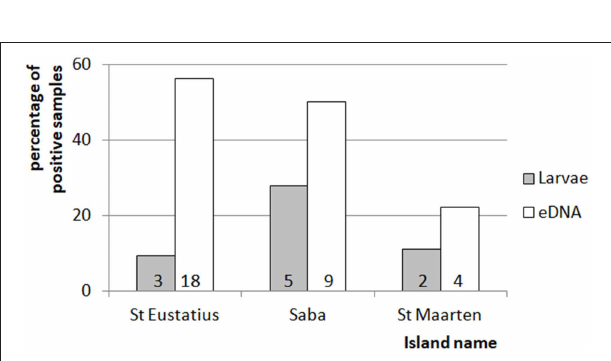
FIGURE 3 | Comparison of between the percentage of positive mosquito samples for the eDNA and traditional dipping method. Indicated is the percentage of times larvae were detected by dipping or eDNA water sampling for each of the islands. The numbers at the bottom of each of the bars indicate the number of detections for the corresponding method and island. The total amount of dipping and eDNA water samples was 32, 18, and 18 for St. Eustatius, Saba, and St. Maarten